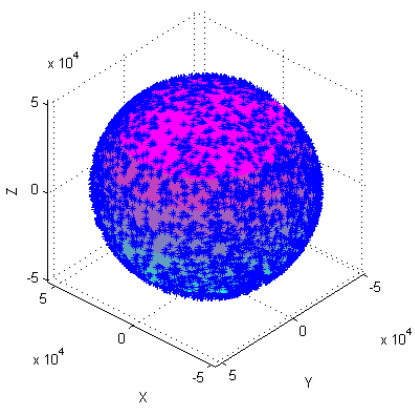
Figure 7. Optimal ellipsoid fitting (EF4).